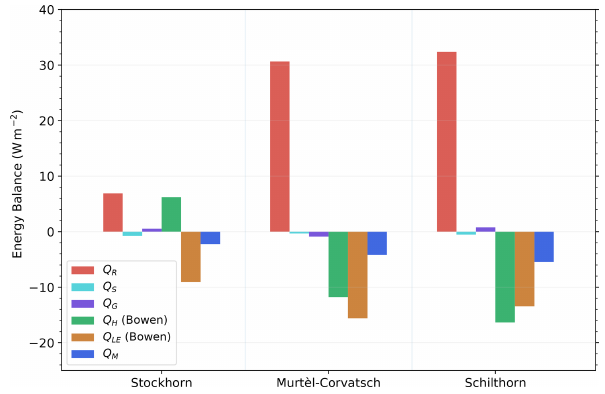
Figure 6. Mean energy balance components for all three stations for the whole observation period: Murtèl–Corvatsch (1997–2018), Schilthorn (1999–2018) and Stockhorn